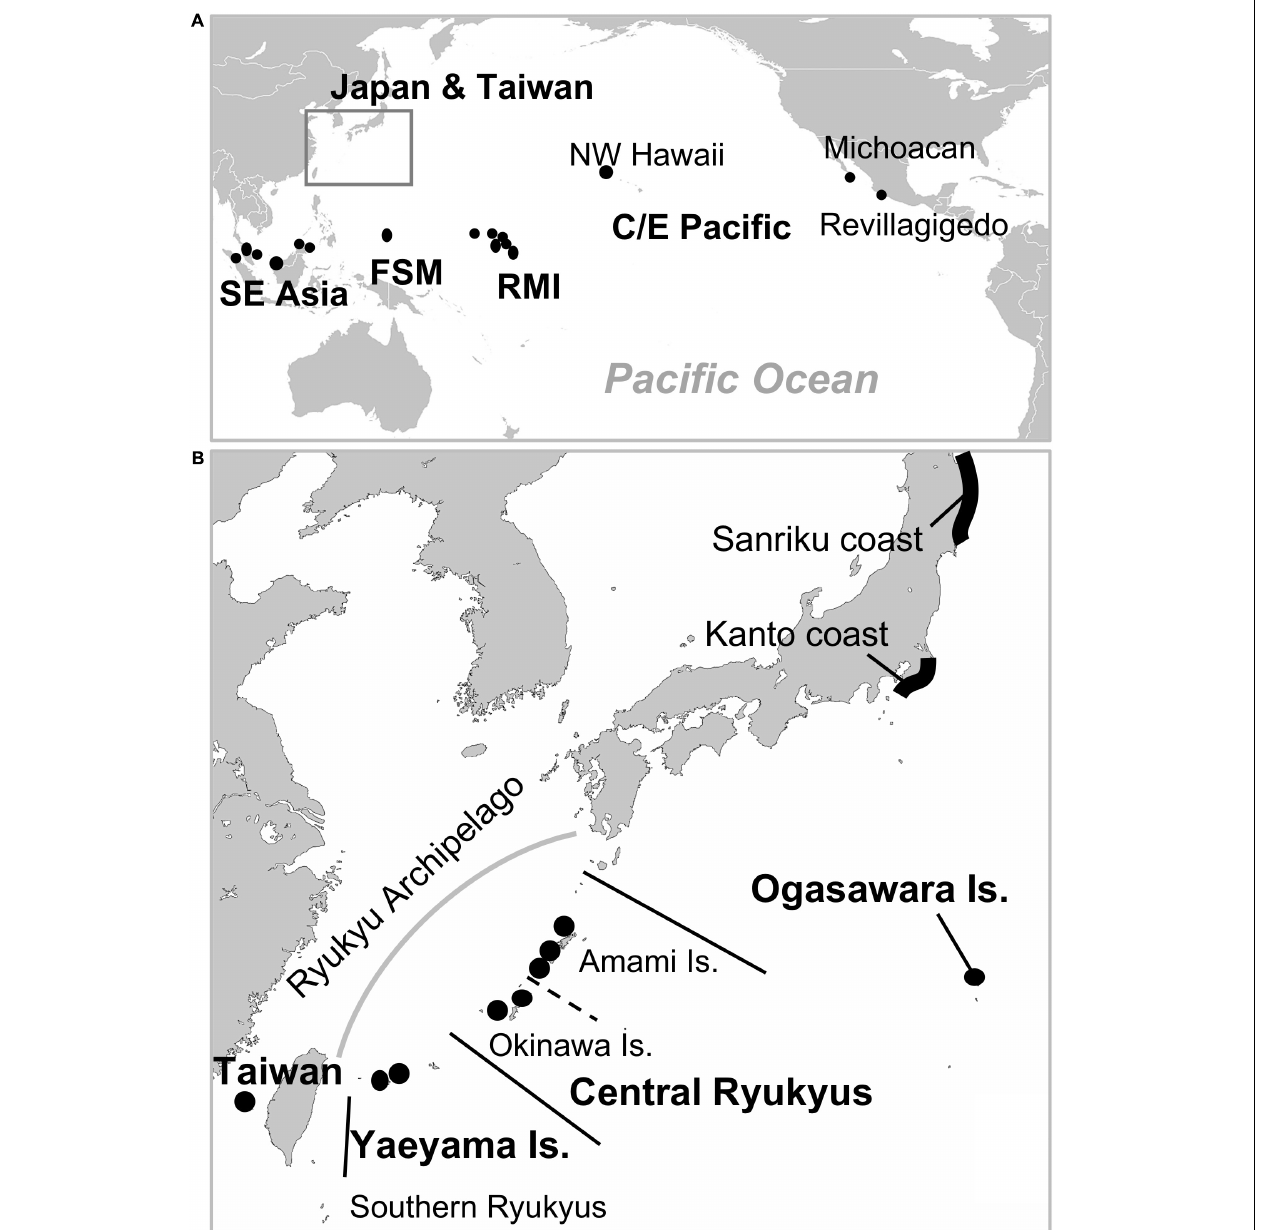
FIGURE 1 | Map of study area (A) and enlarged map around Japan (B) . Black dots show the sampling nesting sites (in Japan) and the candidate natal origins of turtles that were included as samples from the nesting populations outside of Japan in this study. Abbreviations of locations are as follows: SE Asia, Southeast Asia; FSM, Federated States of Micronesia; RMI, Republic Marshall Islands; NW Hawaii, Northwestern Hawaii; C/E Pacific, Central/Eastern